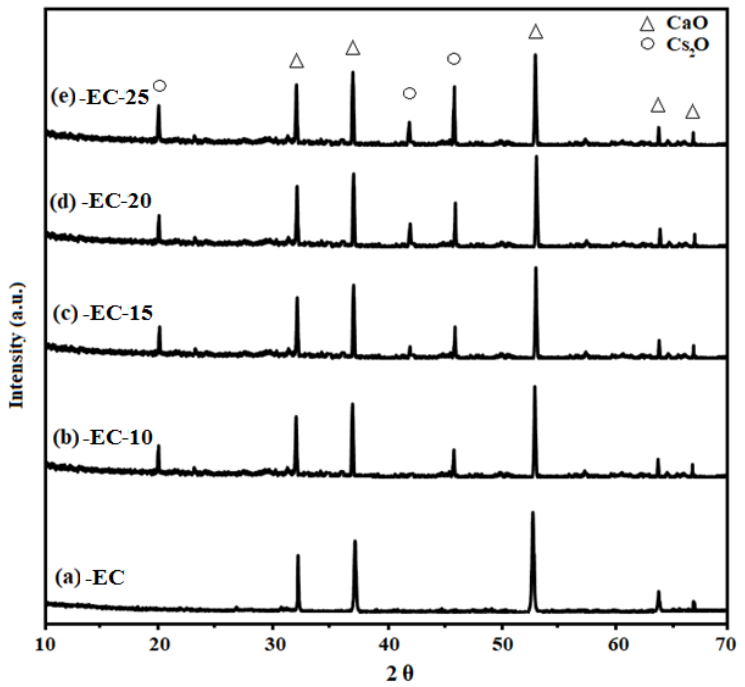
Figure 1. Catalyst analysis by XRD: ( a ) lime (CaO) derived from waste eggshells, ( b ) lime modified by 10 wt.% of caesium oxide, ( c ) lime modified by 15 wt.% of caesium oxide, ( d ) lime modified by 20 wt.% of caesium oxide and ( e ) lime modified by 25 wt.% of caesium oxide.